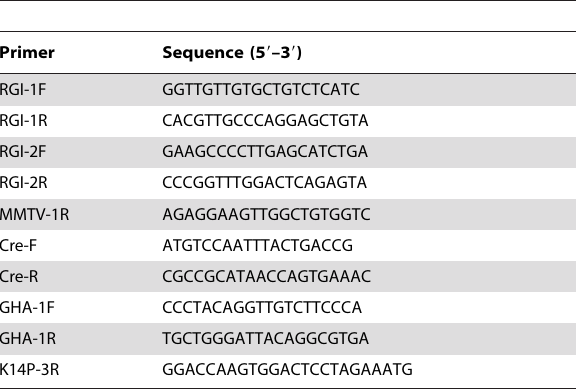
Table 1. Primers used for inverse PCR and genotyping the MMTV-Cre